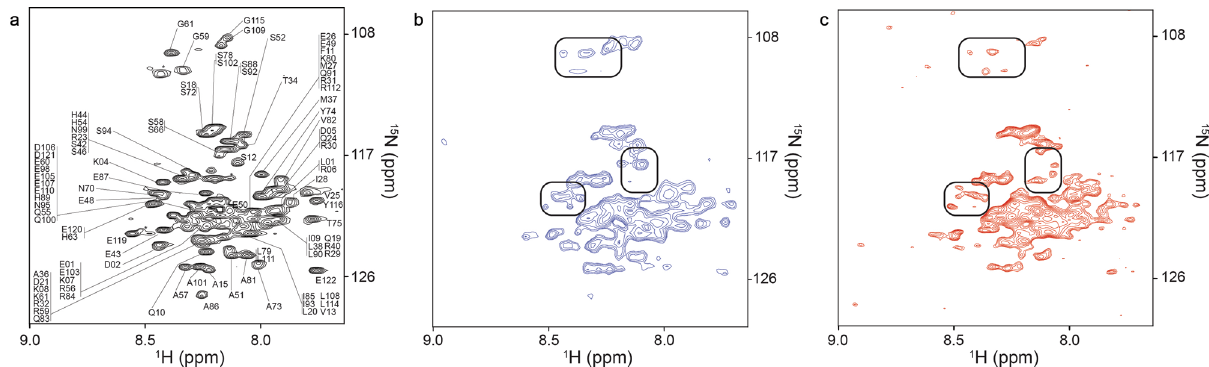
Fig. 3 VECT-transfected cells portray the physiological state. a In vitro 1 H- 15 N CRINEPT-HMQC-TROSY spectrum of [ U - 2 D, 15 N]-DARPP-32 1-122 . b In- cell 1 H- 15 N CRINEPT-HMQC-TROSY spectrum of VECT-transfected [ U - 2 D, 15 N]-DARPP-32 1-122 . c In-cell 1 H- 15 N CRINEPT-HMQC-TROSY spectrum of electroporation-transfected [ U - 2 D, 15 N]-DARPP-32 1-122 . Boxed regions highlight differences in 1 H- 15 N cross peak resolution between electroporated and VECT-transfected HeLa